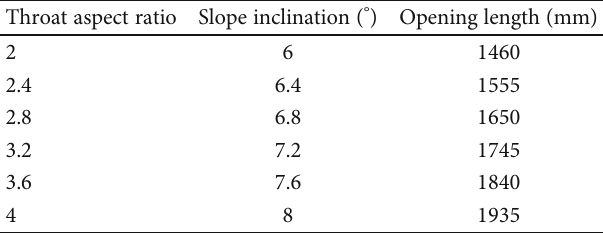
Table 1: Structure